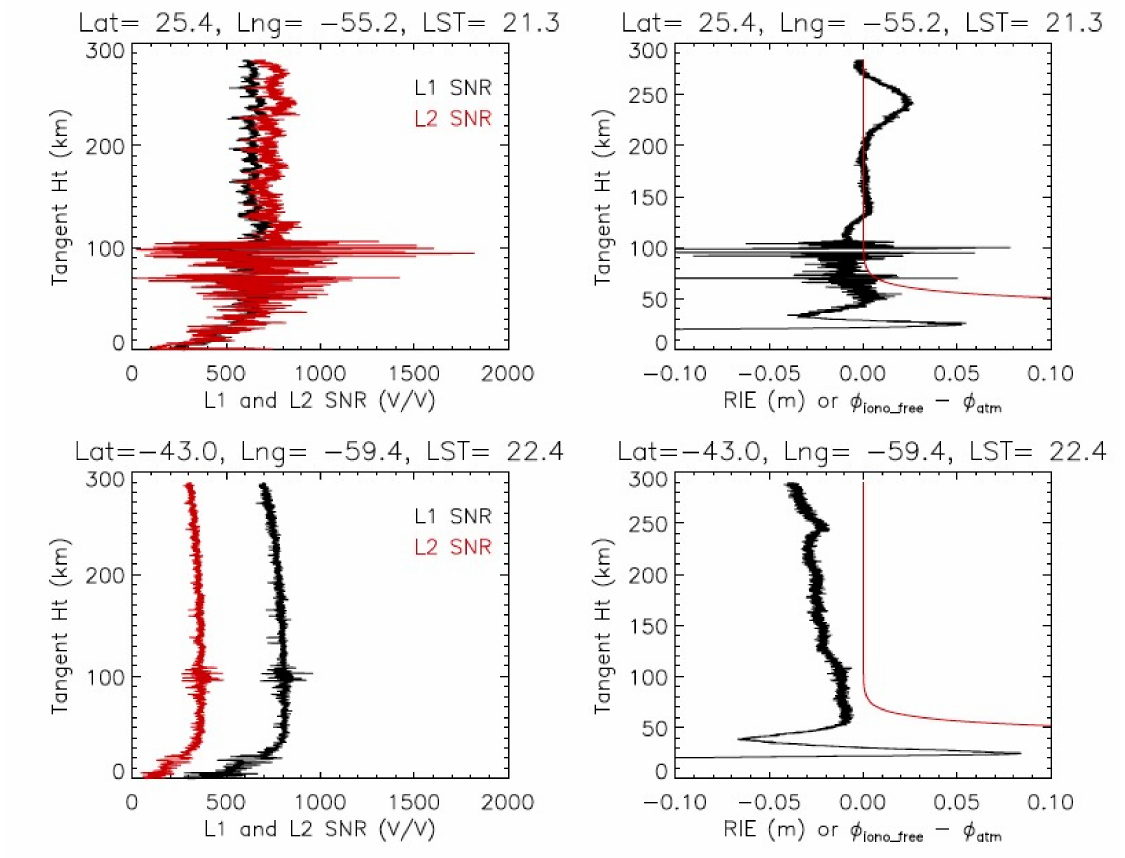
Figure 2. Two examples of the RIE in the MetOp-A RO profiles from 2020d162: SNR profiles ( left panels) and RIE profiles ( right panels). The red line in the right panels is φ atm . The F -region and E s - induced RIEs are evident in the first case ( top panels), whereas the sloped RIE profile is shown in the second case ( bottom panels). The vertical gradient φ iono _ free profile from RIEs is ~1.25 × 10 − 4 m/km, or ~1.25 × 10 − 7 in radians, along with a bias of 0.03